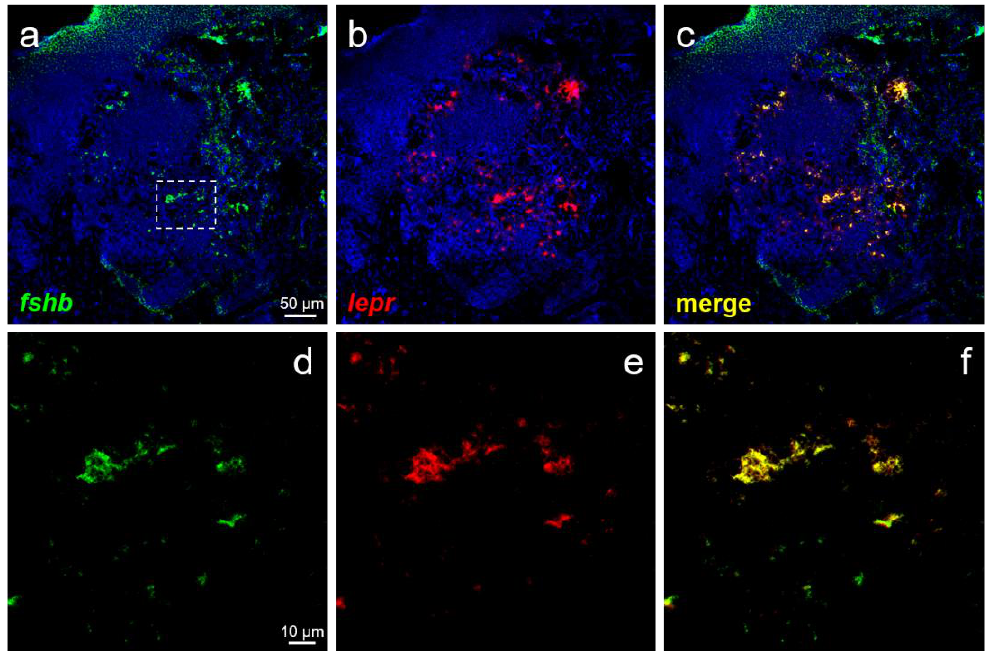
Figure 6. Double-label ISH in the pituitary of females. ( a ) Green fluorescence indicates the fshb mRNA-expressing cells. ( b ) Red fluorescence indicates the lepr mRNA-expressing cells. ( c ) Merged image of ( a ) and ( b ). ( d – f ) Magnified images of FSH-producing cells (the area surrounded by a square in panel a ) showed that FSH-producing cells co-expressed lepr mRNA. ( a – c ): scale bars = 50 μm; ( d – f ) : scale bars = 10 μm.